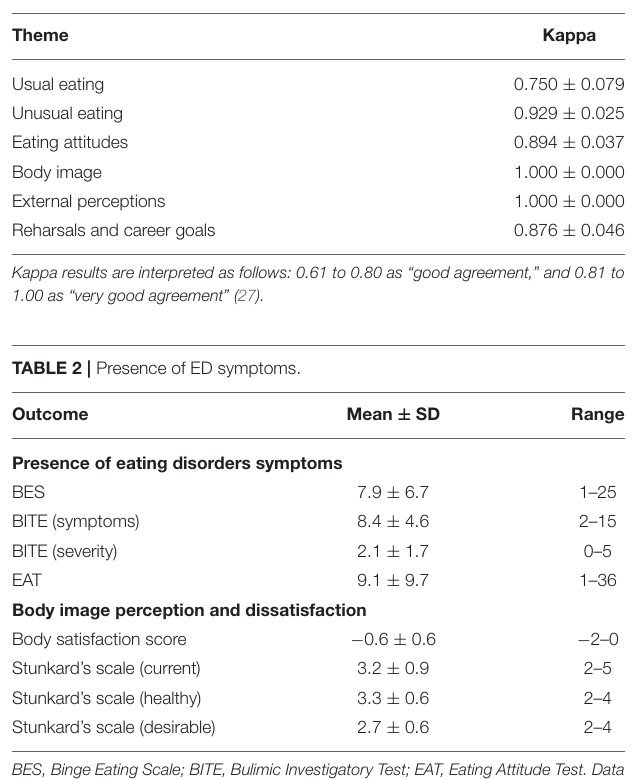
TABLE 1 | Codes and kappa coefficients from focus groups.